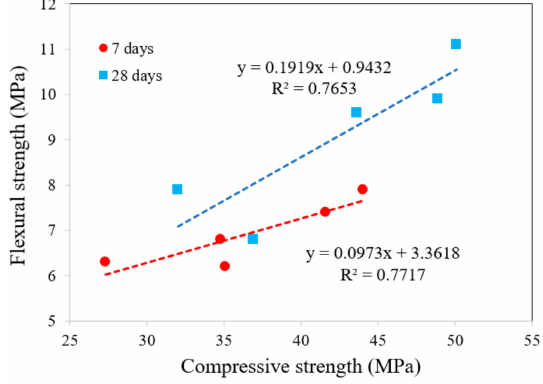
Figure 4. Relationships between averaged compressive and flexural strengths at seven and 28